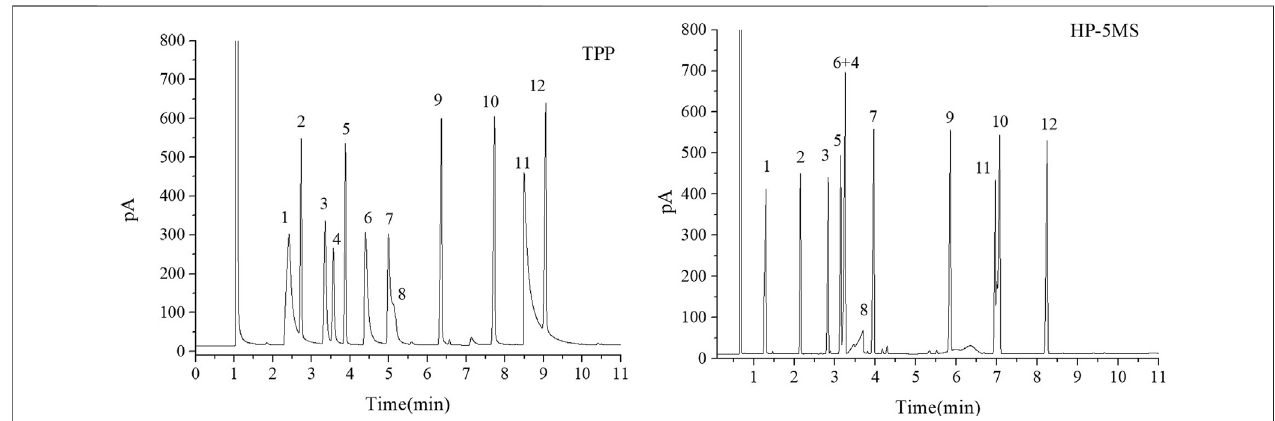
Frontiers in Chemistry |